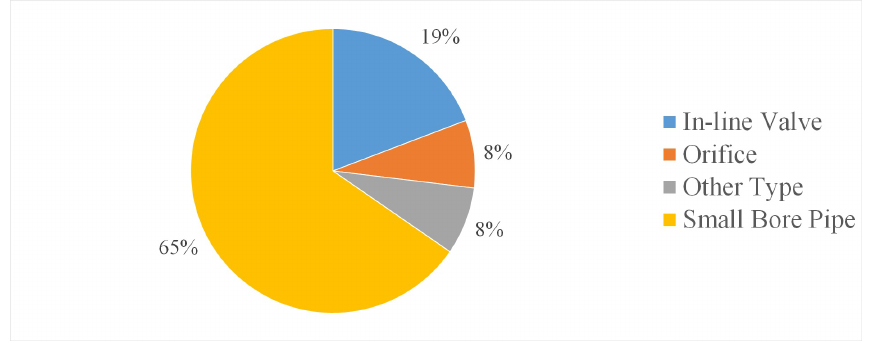
Figure 10. Category #6: types of devices used for simulating PBs.